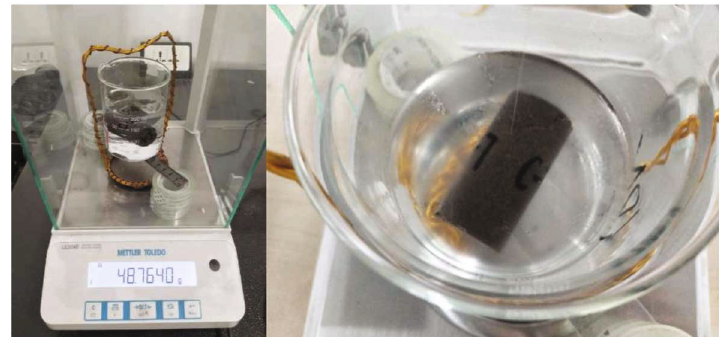
Figure 6: Water absorption experiments of fractured core.